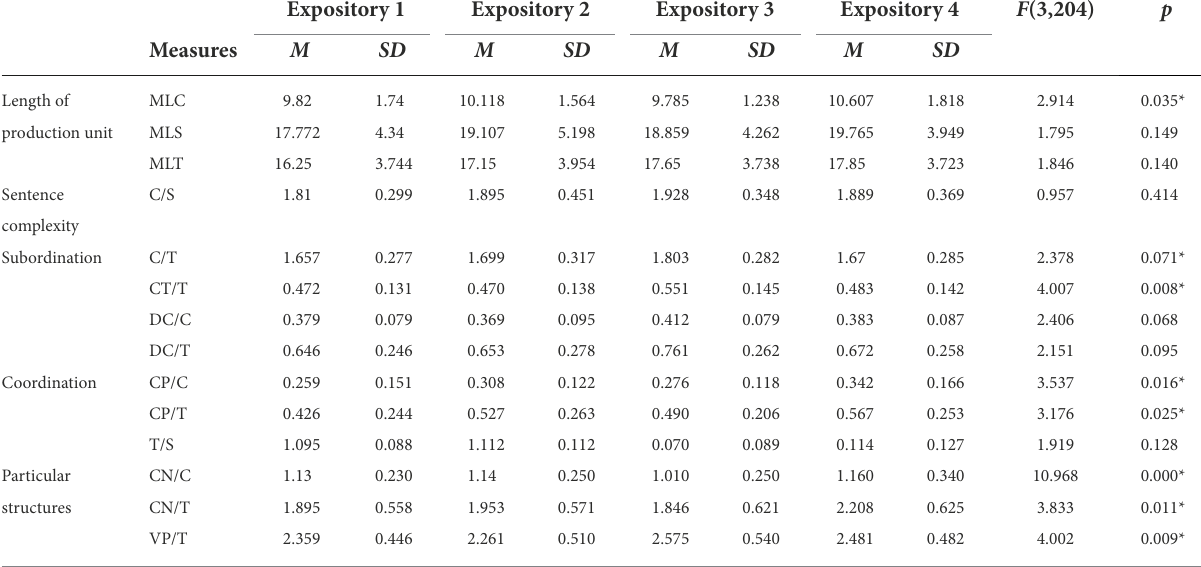
TABLE 4 The effect of time on the syntactic complexity of expository